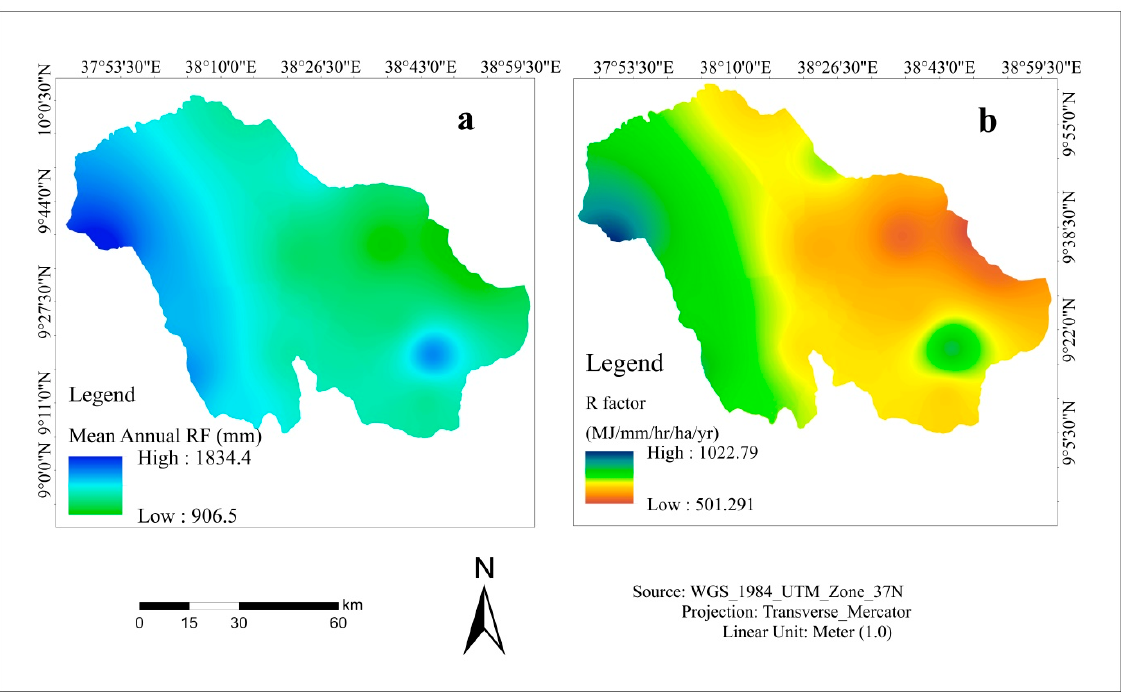
Figure 4. Mean annual Rainfall (mm) ( a ) and Rainfall erosivity (R) factor ( b ) of the Muger sub-basin.